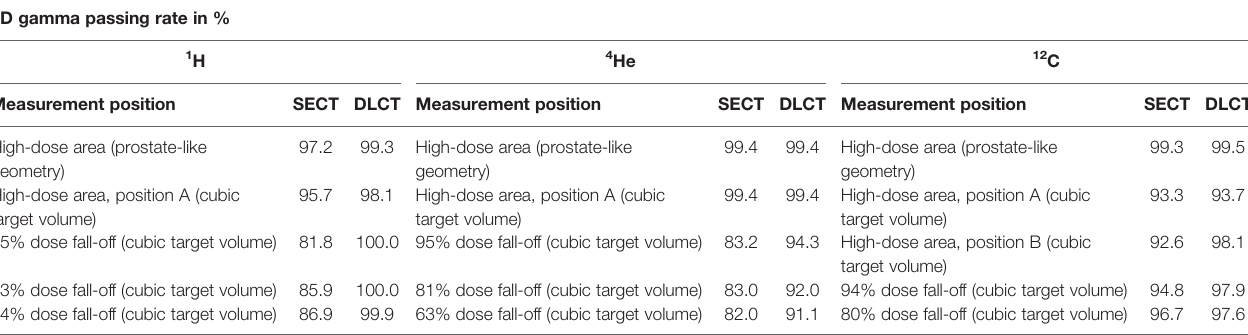
TABLE 5 | 3D gamma passing rates (3%/1.5 mm) using local calculation between SECT- and DLCT-based dose distributions and dosimetric measurements acquired with the OCTAVIUS ® ionization chamber array using the anthropomorphic pelvic phantom. 3D gamma passing rate in